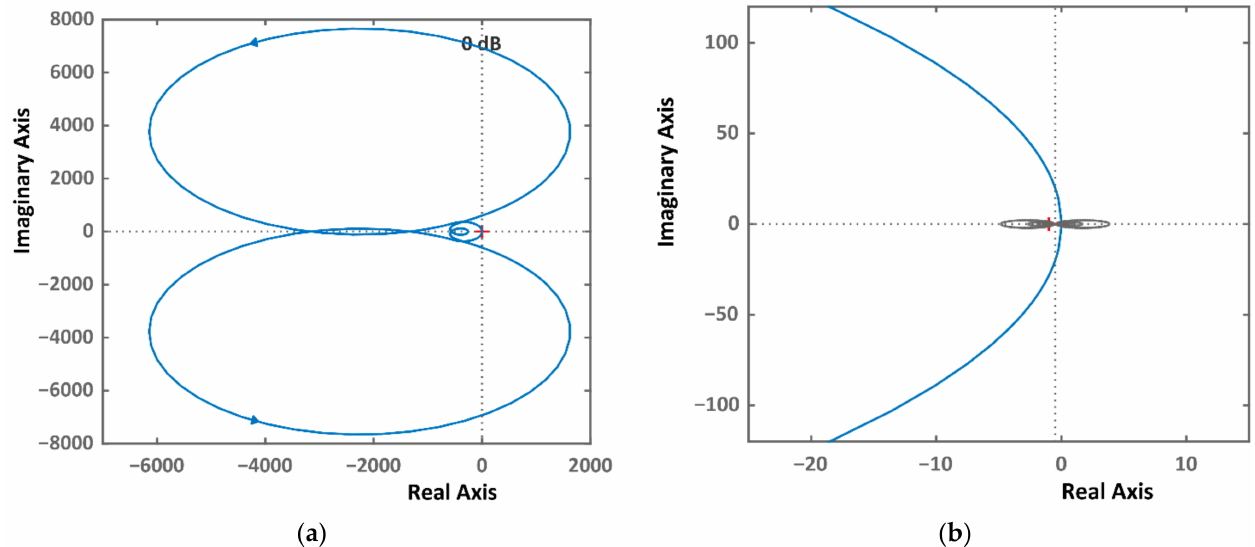
Figure 18. Impedance ratio. ( a ) Nyquist plot under balanced grid condition with conventional mmc controller; ( b ) zoom in ( − 1,